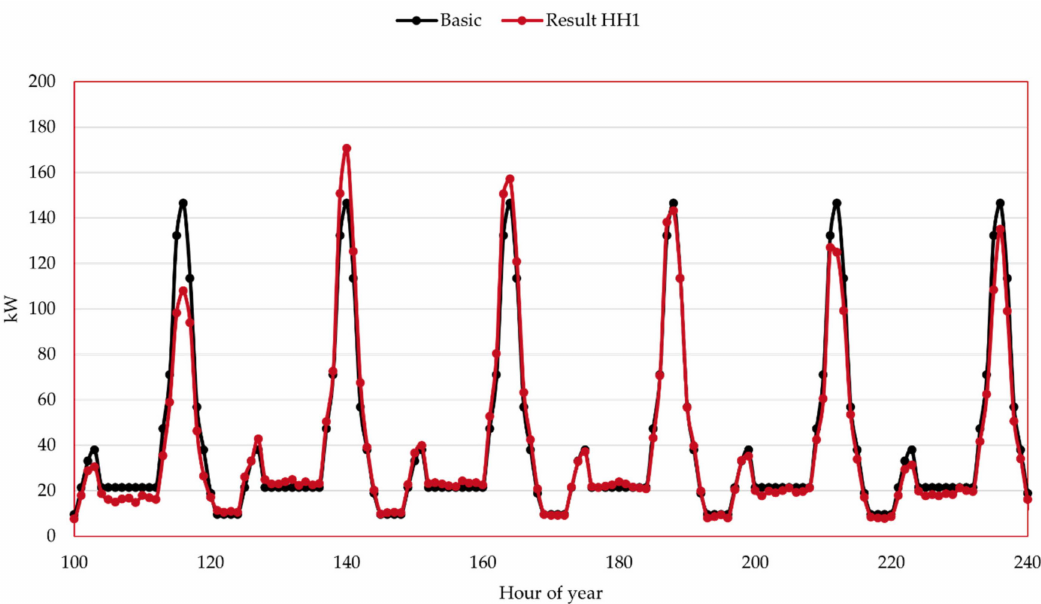
Figure A2. Example of applying the random day-to-day and time-step-to-time-step variability to the load profile of a household consumer.